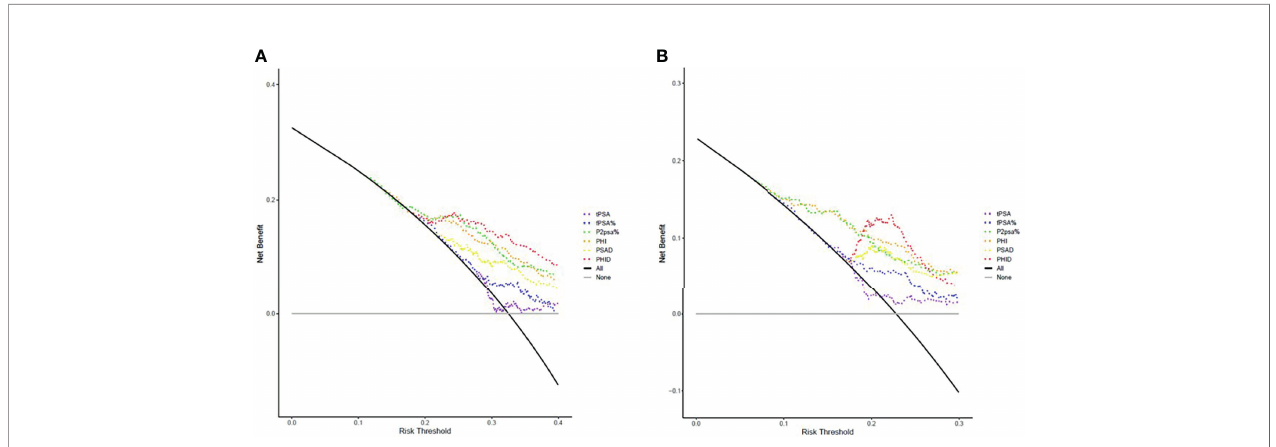
FIGURE 2 | Decision curve analysis (DCA) of various models on (A) PCa detection and (B) csPCa detection in comparison to biopsy-all (black curve line) and biopsy-none strategies (grey horizontal line). The markers of the best clinical bene fi t in the diagnosis of PCa and csPCa are list in order as follows: PHID, PHI, %p2PSA, PSAD, %fPSA and tPSA. Model of PHID (red dotted line) resulted in greater net bene fi t in overall PCa and csPCa detection at probability threshold range 20% to 30%.